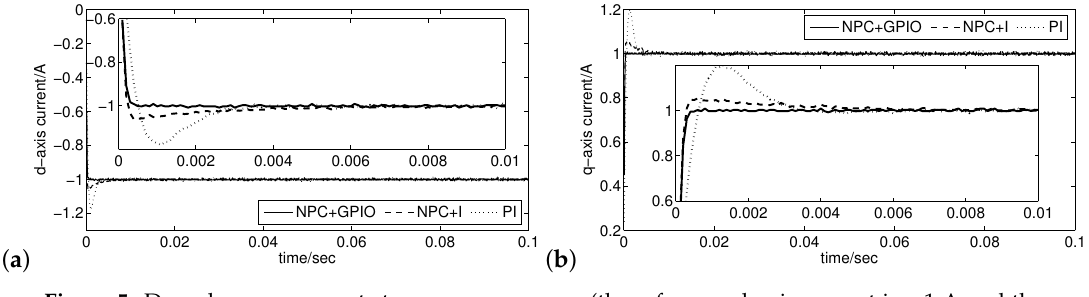
Figure 5. D- and q-axes current step response curves (the reference d-axis current is − 1 A and the reference q-axis current is 1 A) in the case of nominal model under the proposed controller (NPC + GPIO), the integral controller (NPC + I) and the improved PI controller: ( a ) d-axis; ( b )